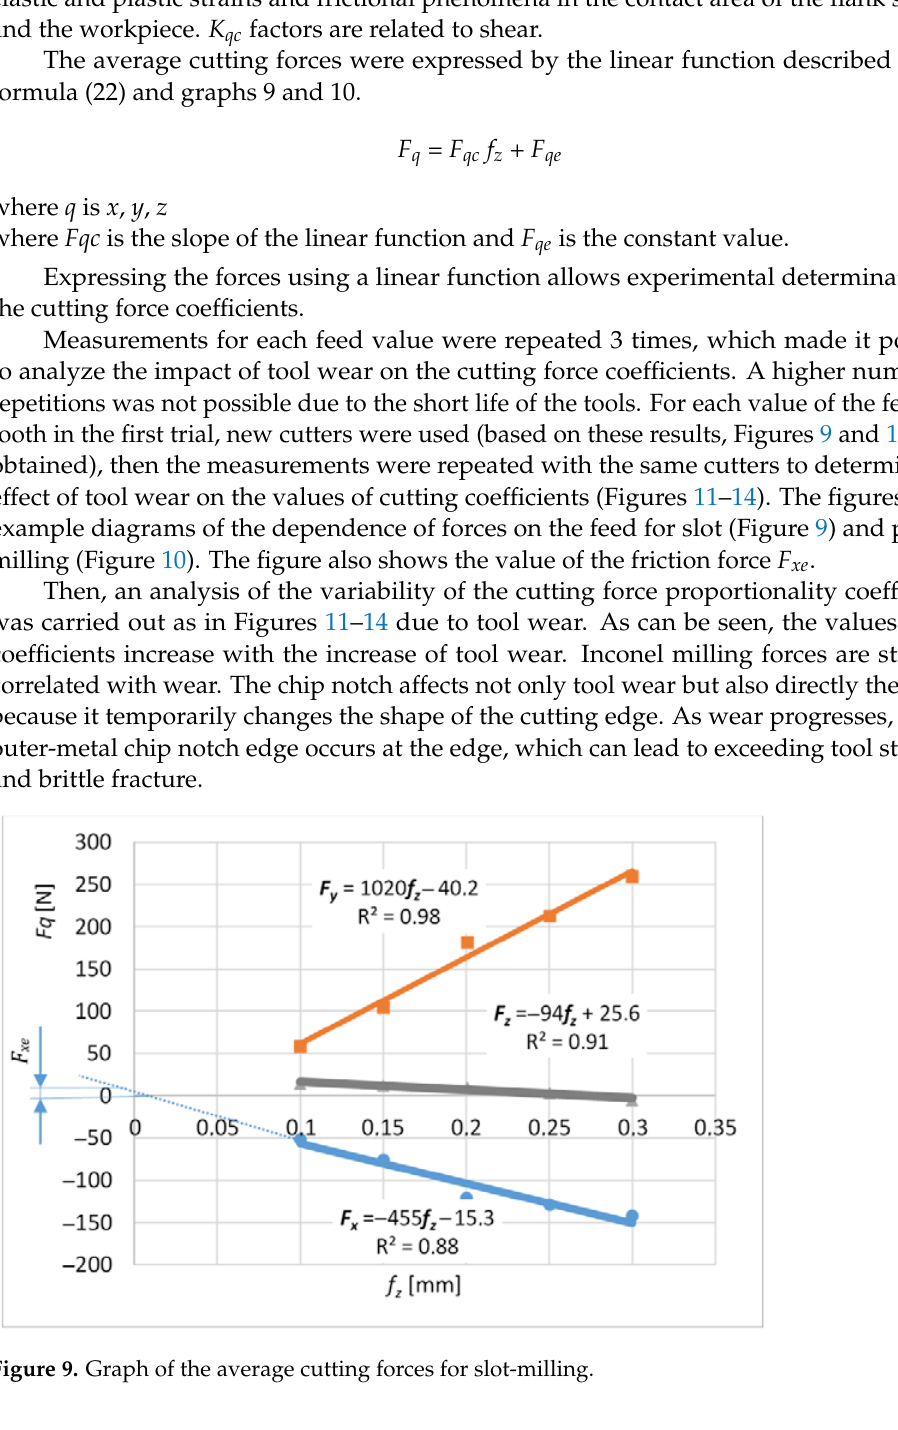
Figure 10. Graph of the average cutting forces for plunge milling. Then, an analysis of the variability of the cutting force proportionality coefficients was carried out as in Figures 11–14 due to tool wear. As can be seen, the values of the coefficients increase with the increase of tool wear. Inconel milling forces are strongly cor- related with wear. The chip notch affects not only tool wear but also directly the forces because it temporarily changes the shape of the cutting edge. As wear progresses, bigger outer-metal chip notch edge occurs at the edge, which can lead to exceeding tool strength and brittle fracture.